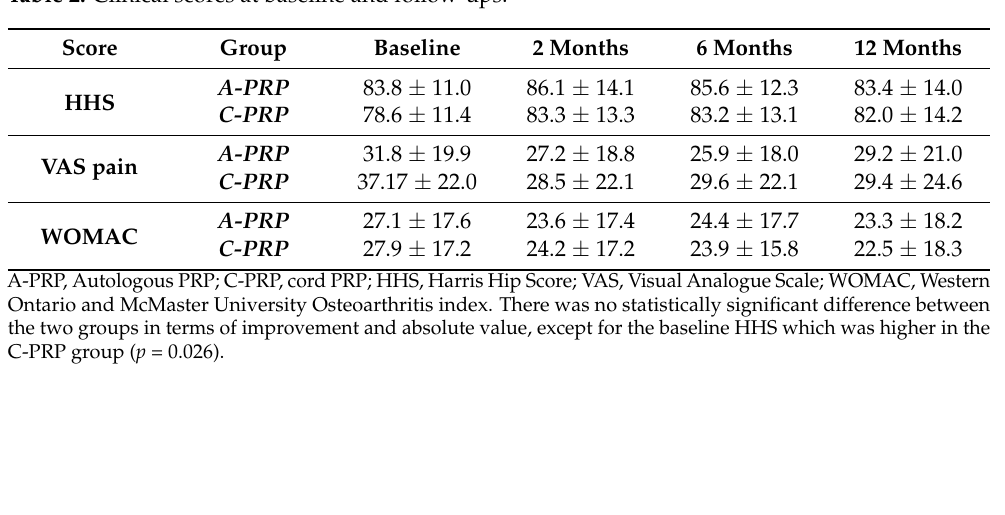
Table 2. Clinical scores at baseline and